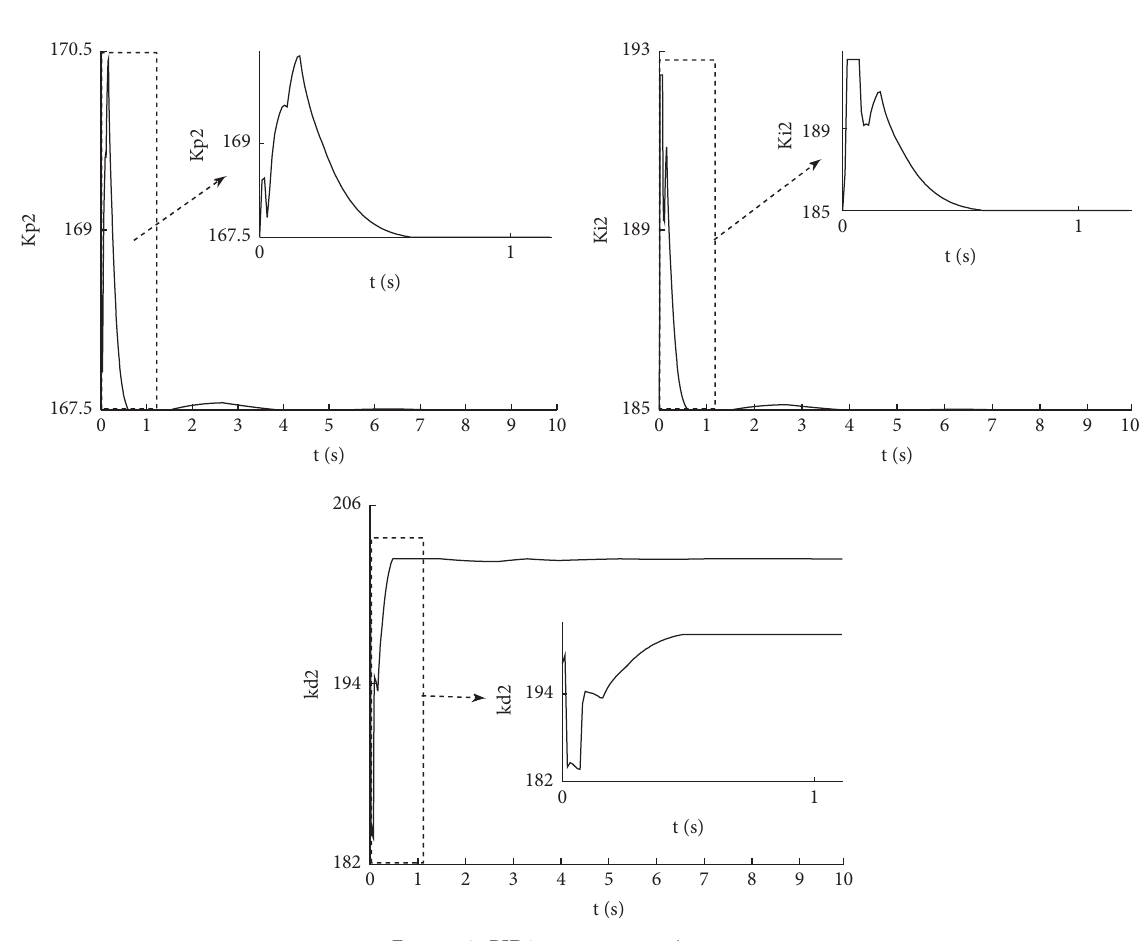
Figure 8: PID2 parameter setting curve. Table 6: Overshoot changes with the mass of the underwater vehicle.